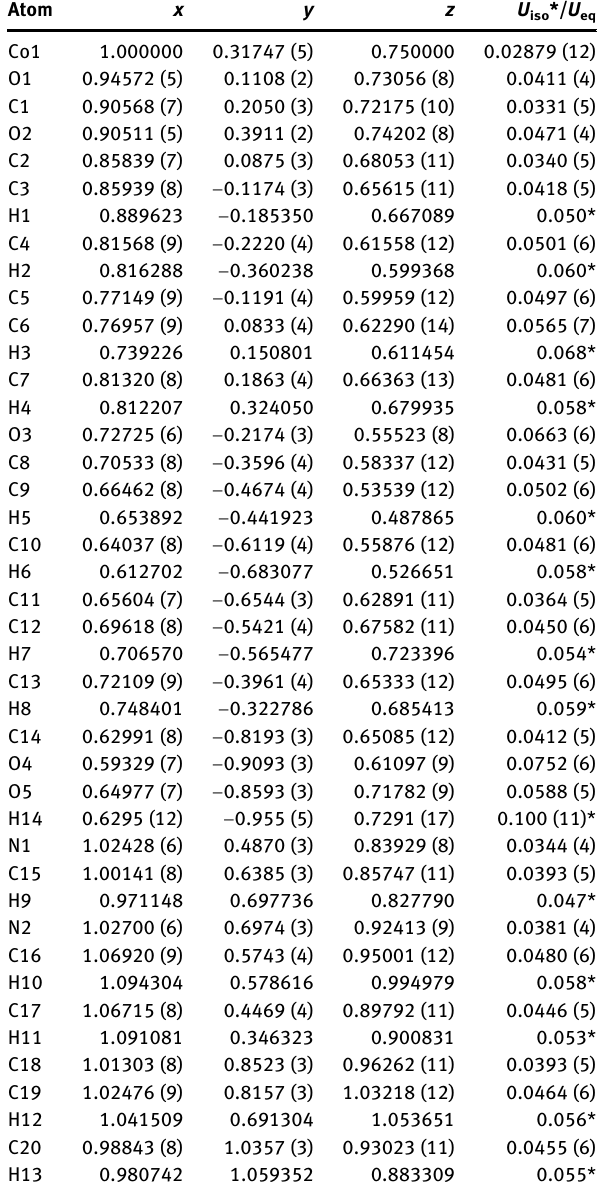
Table  : Fractional atomic coordinates and isotropic or equivalent isotropic displacement parameters (Å 